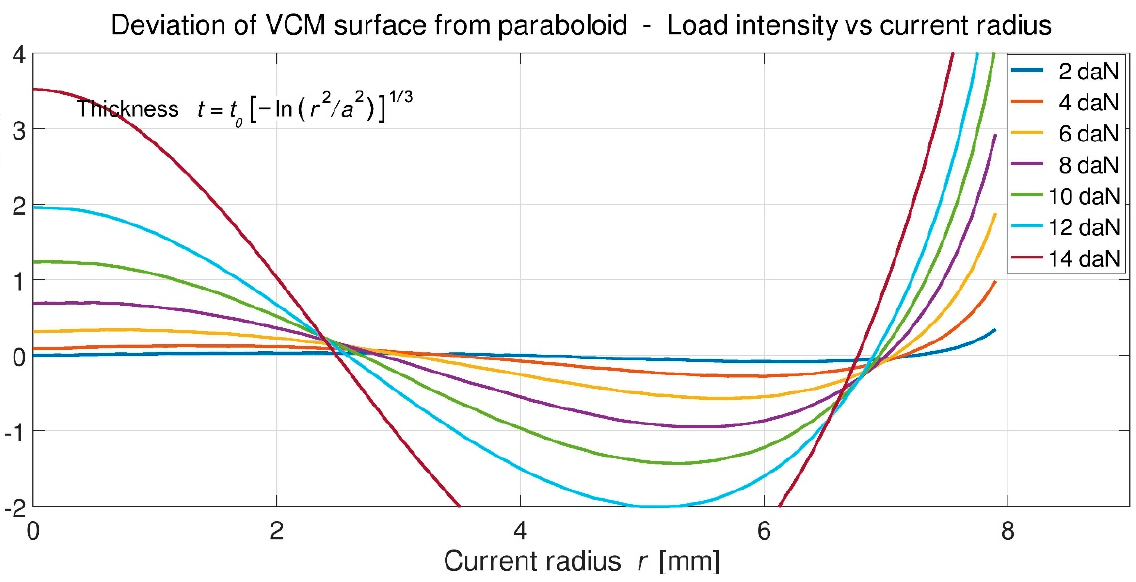
Figure 7. Axial displacements for maximum force F = 14 daN. Mesh model plate-collarette-ring. T = t / t 0 = ( − ln ρ 2 ) 1/3 for 0.05 < ρ < 0.9 and t 0 = 300 µ m. A conical shape is designed for 0.9 < ρ < 1 with t ( ρ = 1) = 120 µ m. Collarette thickness 20 µ m.